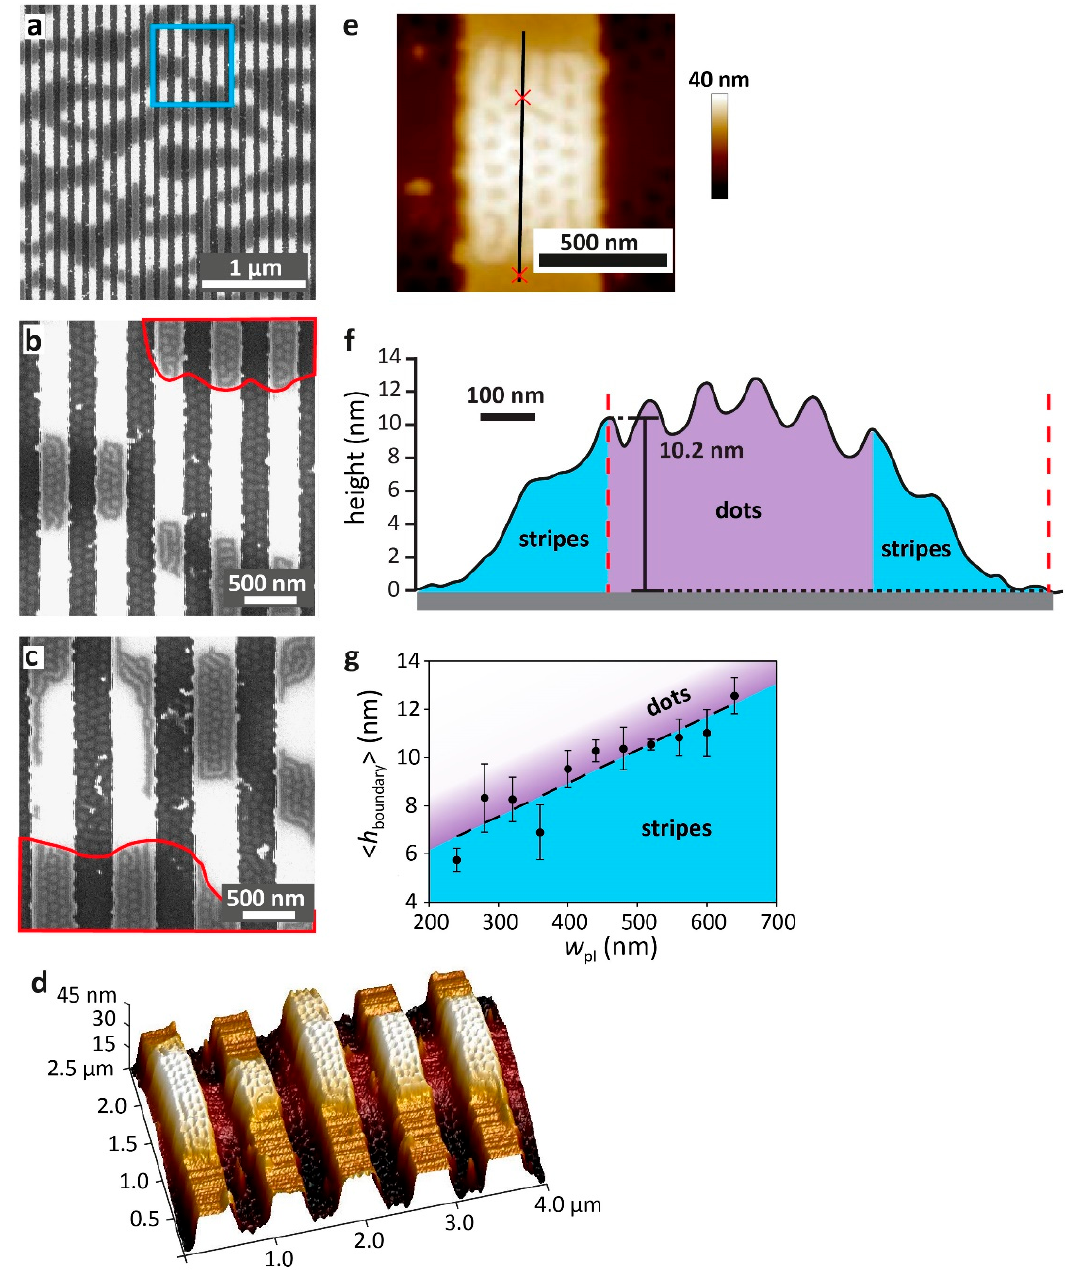
Figure 7. ( a – c ) SEM images of an ultrathin, 8 nm-thick film cast over topographically defined substrates featuring 38 nm-deep trenches. Bright white areas correspond to exposed regions of the plateaus. Lateral dimensions of trench and plateau are 280 ( a , b ) and 400 nm ( c ). ( b ) High magnification image of the blue boxed area in ( a ). Red enclosed areas in ( b , c ) demark film regions that are thicker than the adjacent regions on both the plateau and in the trench. ( d ) Three-dimensional SFM height image of the sample shown in ( a ). ( e , f ) SFM image and corresponding cross-section of a typical dewet area on the plateau, showing the transition (from top to bottom in ( e )) from a pattern of dots at the center of the dewet area through a pattern of stripes to the exposed plateau surface. ( g ) Graph of the local film height at the boundary where the dot pattern transitions to a stripe pattern. Error bars represent the standard deviation in the measurements; the dashed line represents the linear regression. Blue and purple shaded regions in the graph denote the ranges of local film thicknesses where stripes and dots are observed, respectively.